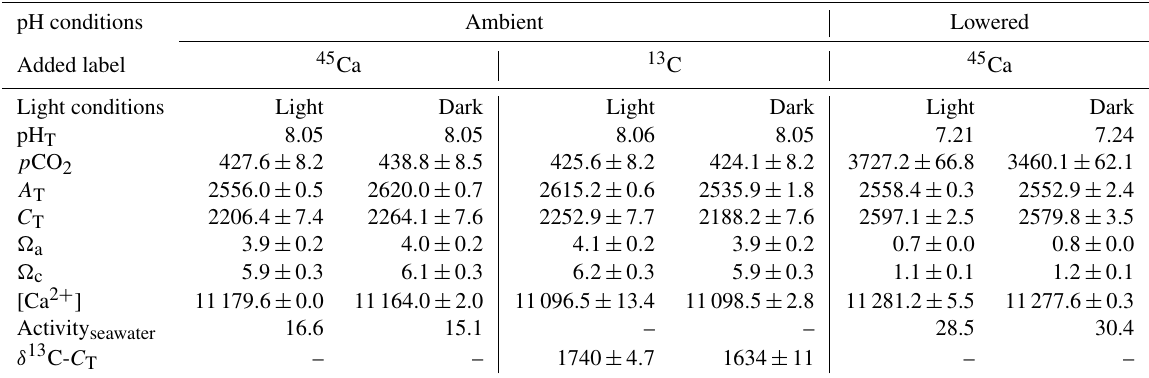
Table 2. Environmental conditions at the start of incubations of the coral Stylophora pistillata . pH on the total scale (pH T ), partial pres- sure of CO 2 ( p CO 2 , µatm), total alkalinity ( A T , µmolkg − 1 ), dissolved inorganic carbon ( C T , µmolkg − 1 ), saturation states with re- spect to aragonite ( (cid:127) a ) and calcite ( (cid:127) c ), and calcium concentrations ([Ca 2 + ], µmolkg − 1 ) are presented. Labeled seawater 45 Ca activity (Activity seawater , BqmL − 1 ) and the isotopic level, after enrichment, of the seawater dissolved inorganic carbon pool ( δ 13 C- C T , ‰) are also shown. Means ± standard deviation (SD) of analytical triplicates (duplicates for δ 13 C- C T ) are shown when available. All incubations were conducted at 25 ± 0 . 5 ◦